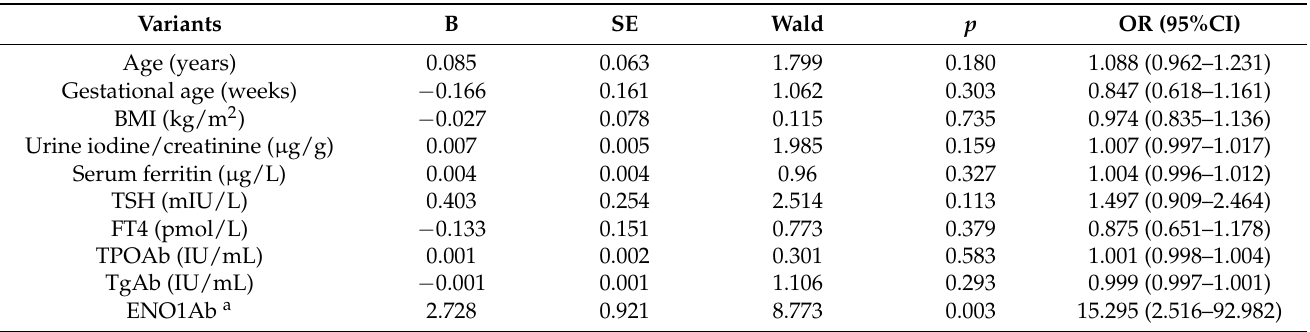
Table 1. Logistic regression of potential risk factors of miscarriage in euthyroid pregnant women with AIT.